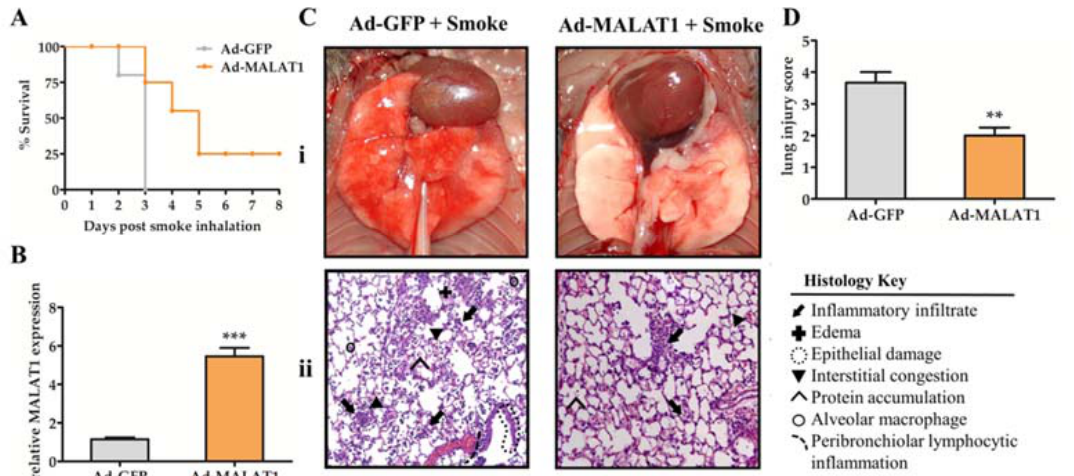
Figure 4. Overexpression of MALAT1 prolonged survival and alleviated lung damage after smoke inhalation. ( A ) Adenovirus MALAT1 (Ad- MALAT1 ) or adenovirus green fluorescent protein (Ad-GFP) was delivered into mice’s lungs 3 days before the smoke exposure. After 15 min smoke inhalation, the survival was monitored for up to 8 days ( n = 20). ( B ) Verification of adenoviral transfection in the lungs tissues was determined by quantitative RT-PCR analysis. ( C ) Lung injury observation (i) of each group was performed, and the lung tissue sections stained by H&E (ii) were observed under morphological alteration (magnification 200 × ). ( D ) Lung injury scores were calculated from random area of H&E staining sections. Data are represented as means ± SEM ( n = 6). *** p < 0.001, ** p < 0.01 vs. Ad-GFP group.